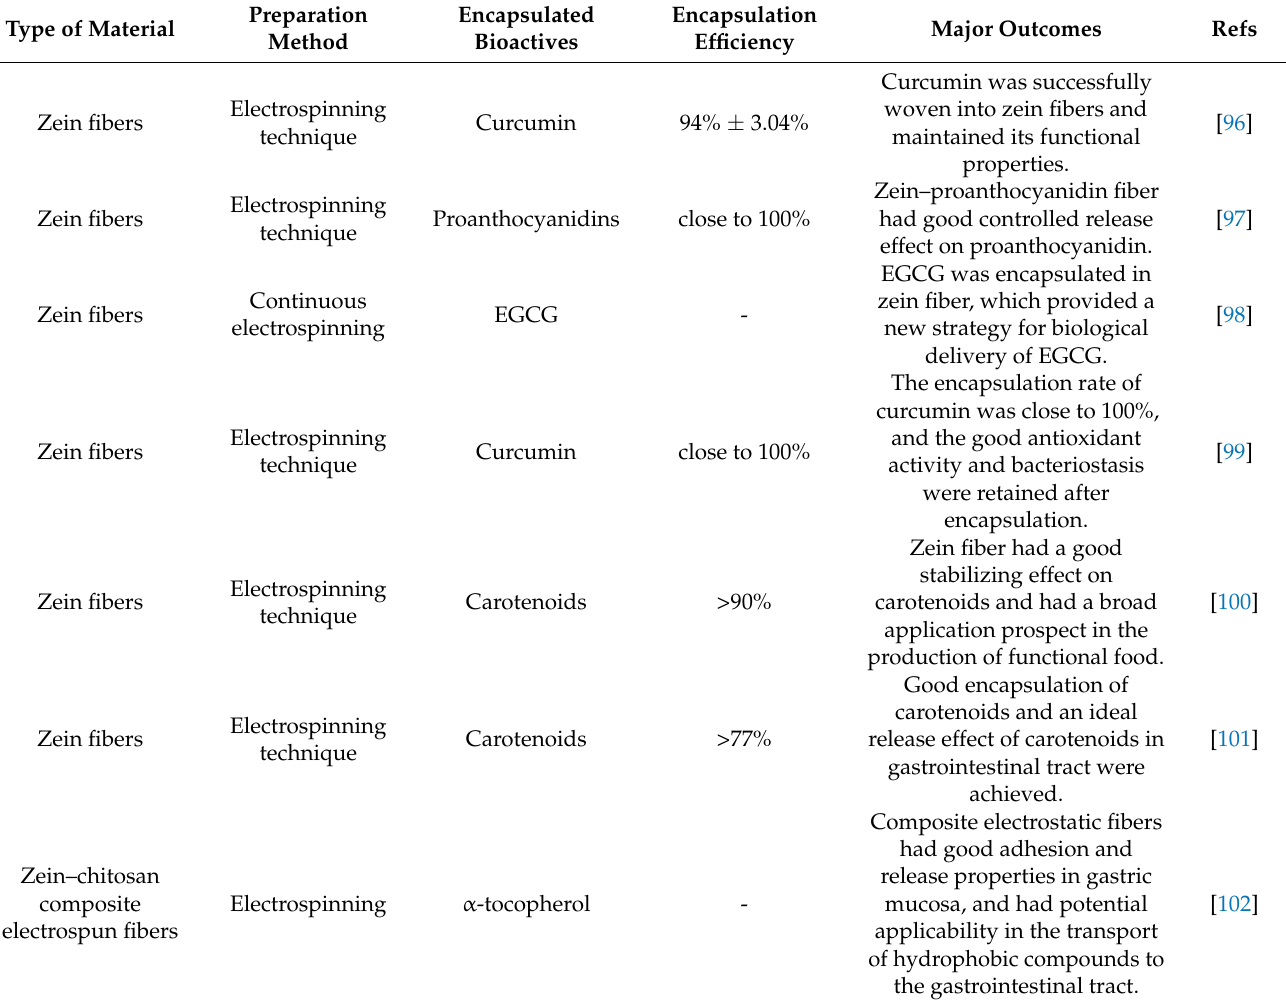
Table 3. Plant protein-based fibers and films for bioactive ingredient